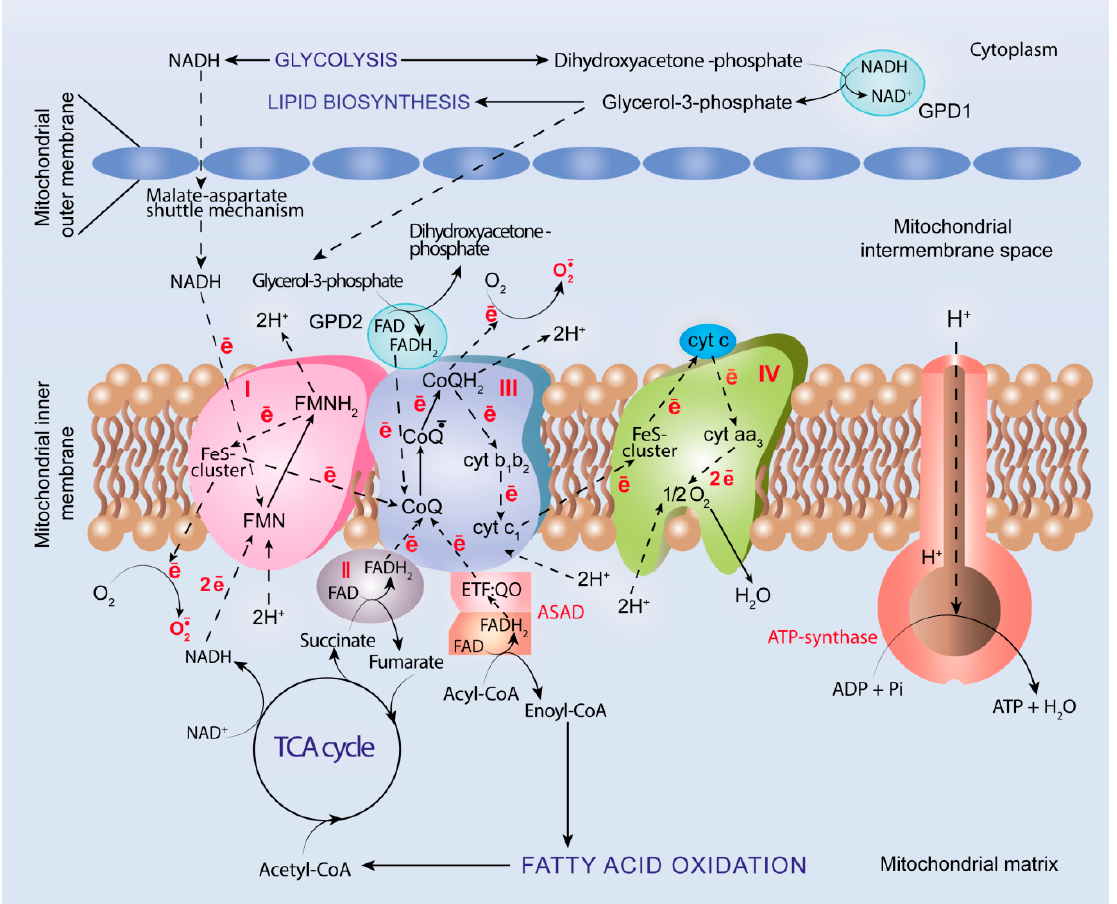
Figure 2. Oxidative metabolism, oxidative phosphorylation (OXPHOS), and reactive oxygen species (ROS) generation. NADH is mainly produced by glycolysis, pyruvate decarboxylase complex (PDC), fatty acid β -oxidation (FAO), and tricarboxylic acid (TCA) cycle to fuel electron transportation chain (ETC) via complex I, whereas FADH 2 is mainly produced by FAO and TCA cycle and fuels ETC via complex III. Glycerol-phosphate and malate-aspartate shuttle mechanisms serve to transfer reducing equivalents through the outer mitochondrial membrane from the cytoplasm to ETC. Superoxide anion radical, a primary type of ROS, is produced as a byproduct of ETC.